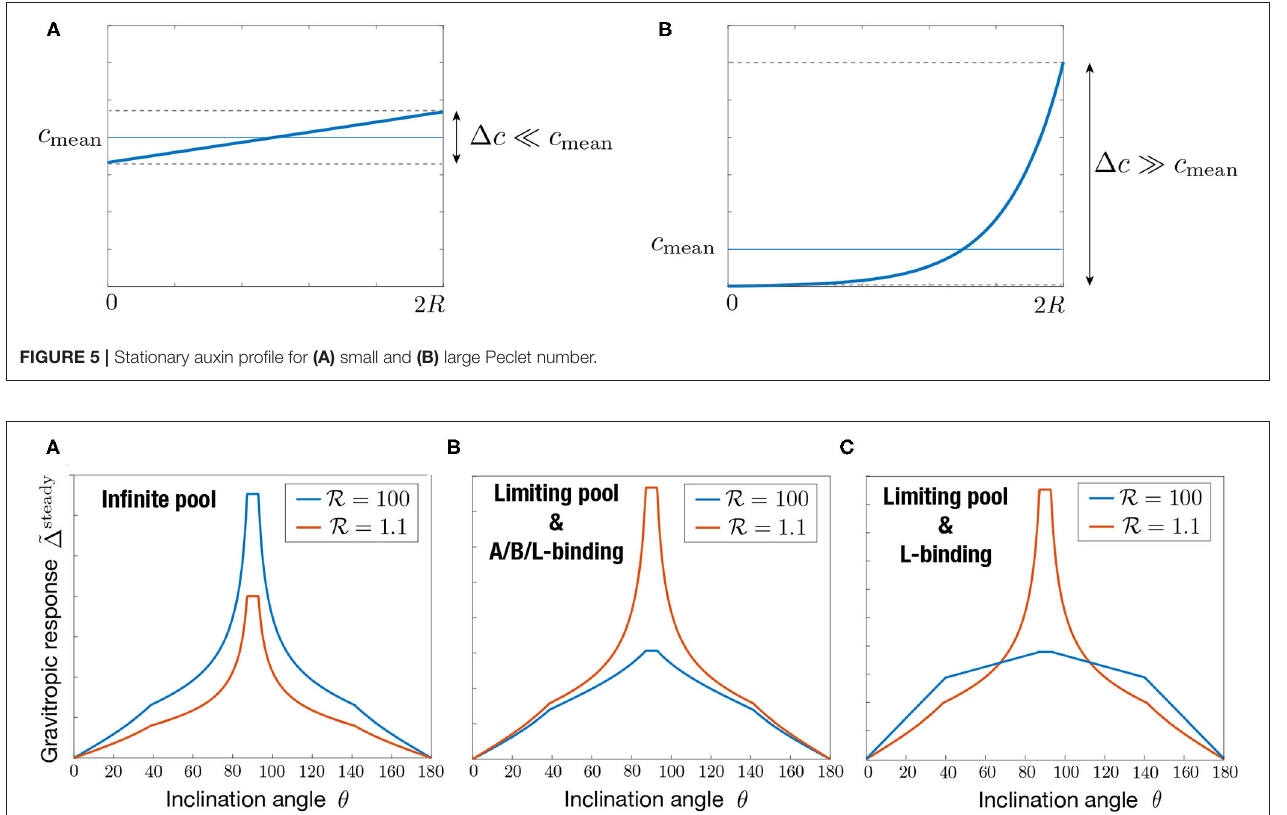
1), (B) limiting pool ( P 1) with apical/basal/lateral binding, (C) limiting pool ( P 1) with lateral binding ≫ ≪ ≪ 4 d , W 10 d , H 25 d where d stands for the diameter of a = = =